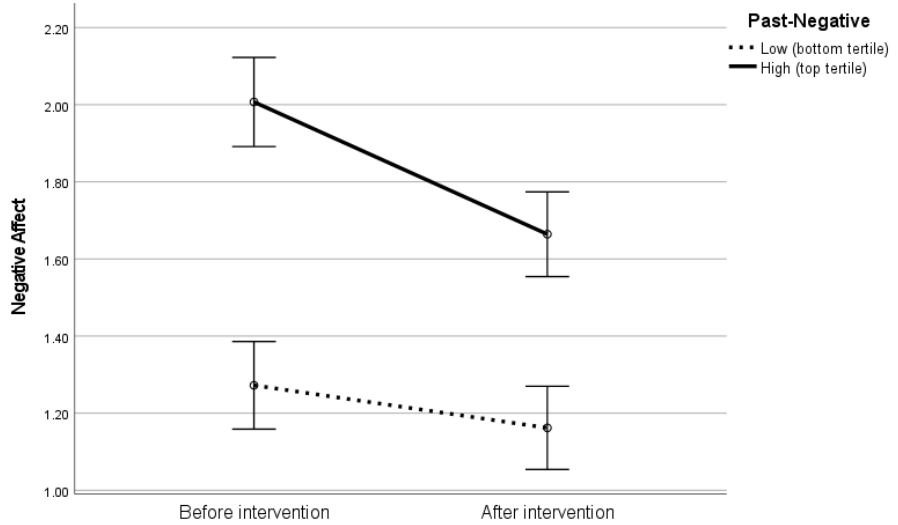
Figure 2. Interaction between gratitude intervention and Past-Negative time perspective in predicting negative affect.